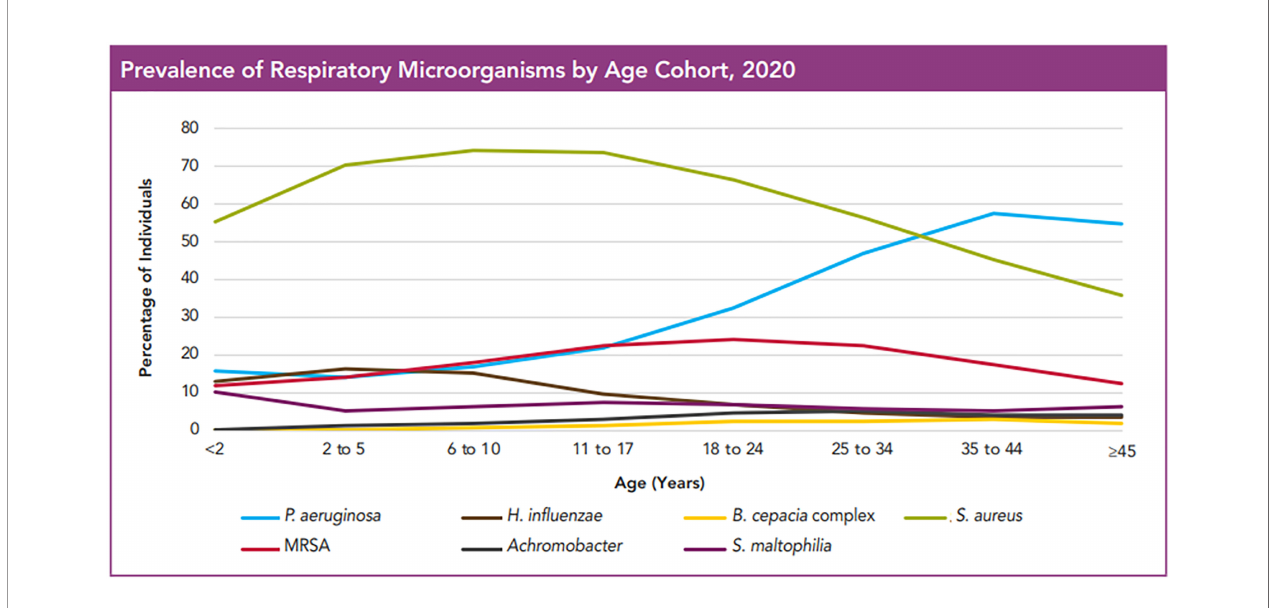
FIGURE 1 | Prevalence of Respiratory Microorganisms by age cohort, 2020. The fi gure shows the prevalence of microorganisms in the respiratory tract of CF patients in different age groups. Even at a very young age, affected individuals have at least one microorganism, and this number increases with increasing age. S. aureus is by far the most widespread microorganism, which is followed with time by P. aeruginosa . What one can also see is that the incidence of MRSA is only about 20% of that of MSSA. Hemophilus in fl uencae , Achromobacter , Burkholderia cepacia and Stenotrophomonas maltophilia were only rarely observed. This image is reproduced with permission from Cystic Fibrosis Foundation Patient Registry, 2020 Annual Data Report, Bethesda, Maryland © 2021 Cystic Fibrosis